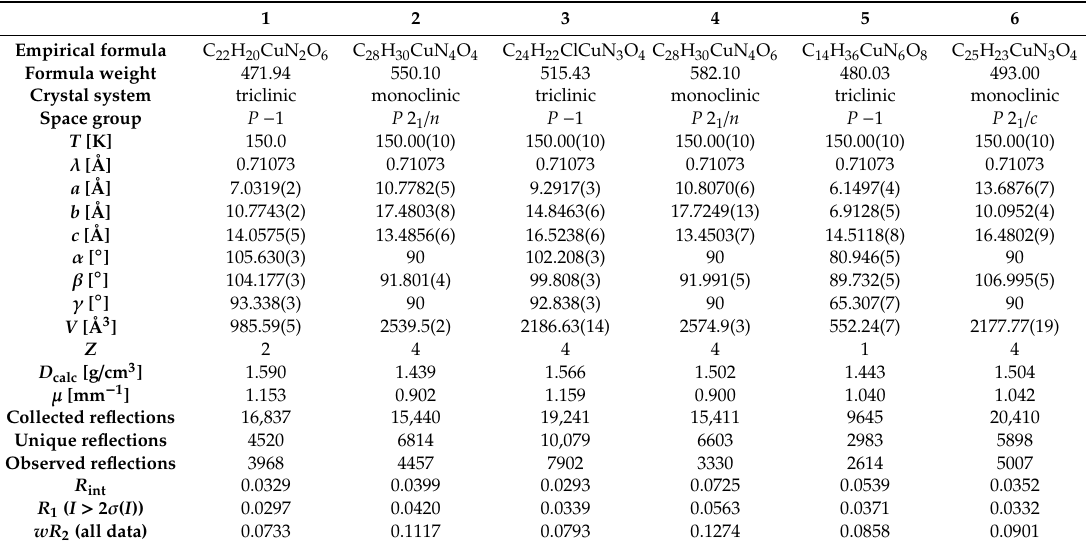
Table 3. Crystallographic data for 1 to 6 .